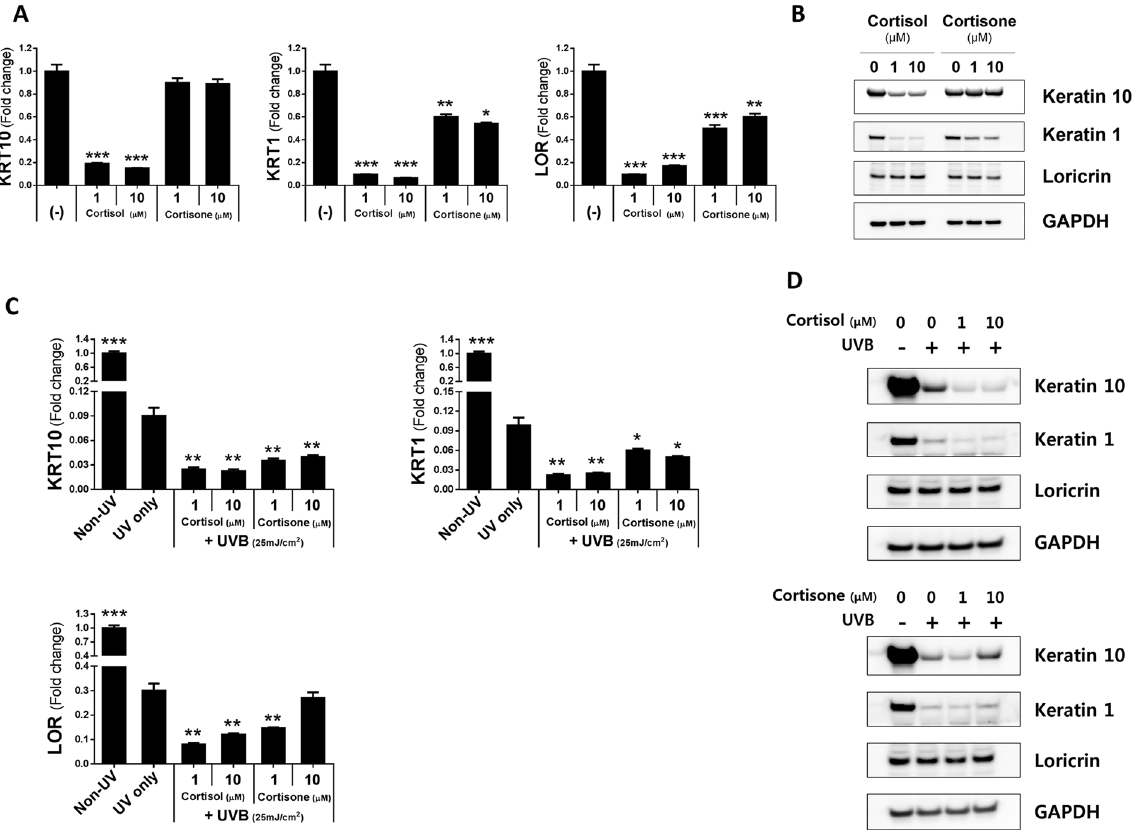
Figure 4. Increased cortisol converted by 11 β -HSD1 inhibits keratinocyte differentiation in vitro (n = 3). ( A ) mRNA expression of keratinocyte differentiation markers (KRT10, KRT1, and LOR) was decreased by cortisol treatment, but was not affected or only slightly affected by cortisone. ( B ) Protein expression of KRT10 and KRT1 was decreased by cortisol, but the protein expression of LOR did not differ upon cortisol treatment. Protein expression of KRT10 and LOR was not affected by cortisone. Cortisone-induced protein expression of KRT1 decreased, but the change was less than that observed upon cortisol treatment at the same concentration. Cortisone decreased the mRNA ( C ) and protein ( D ) expression of keratinocyte differentiation markers (KRT10 and KRT1) in UVB-exposed keratinocytes. Cortisone decreased the mRNA expression of LOR but did not alter its protein expression in UVB-exposed keratinocytes. * p < 0.05; ** p < 0.01; *** p <